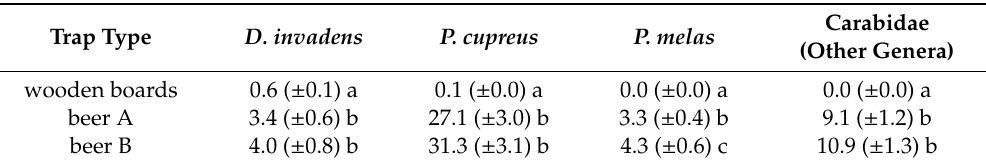
Table 2. Mean catches ( ± SE, n = 208) of D. invadens and ground beetles ( P. cupreus , P. melas and other Carabidae) in trial no. 1 according to the di ff erent type of